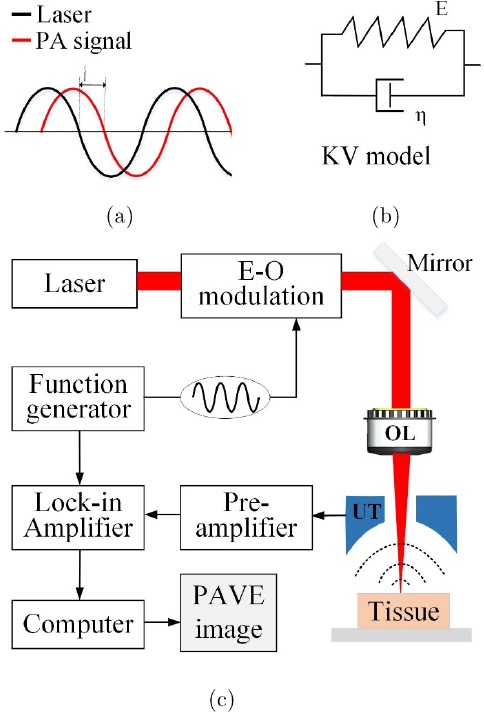
Fig. 1. (a) Principle of the PAVE method. (b) Sketch diagram of the KV model. (c) System of the PAVE